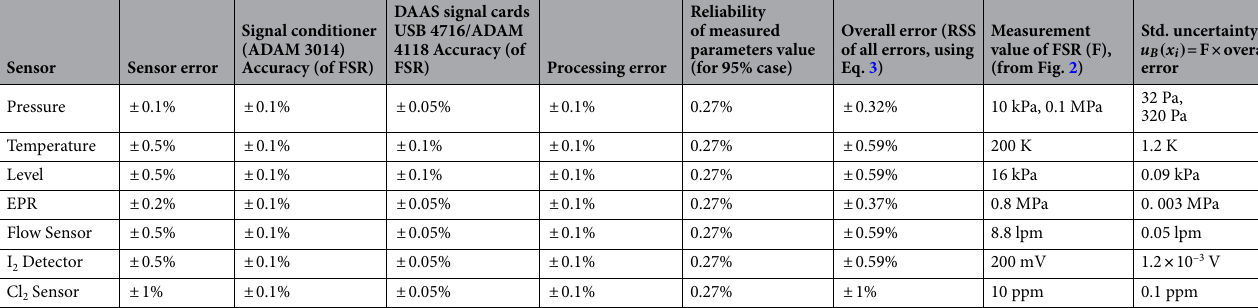
Table 2. Evaluation of Standard uncertainty u B ( x i ) by Type B